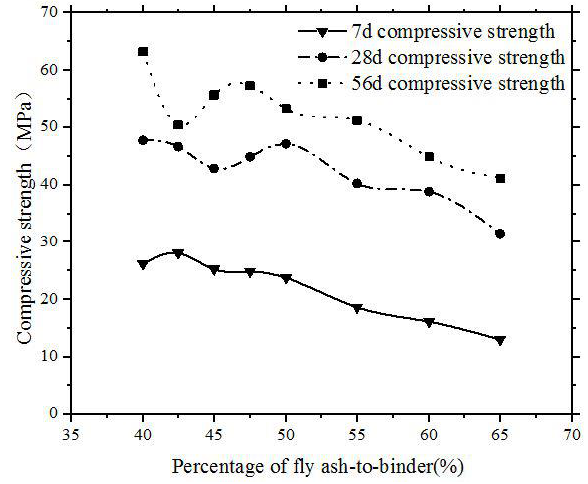
Figure 1. Influence of volume of fly ash on the compressive strength of SCC at different ages